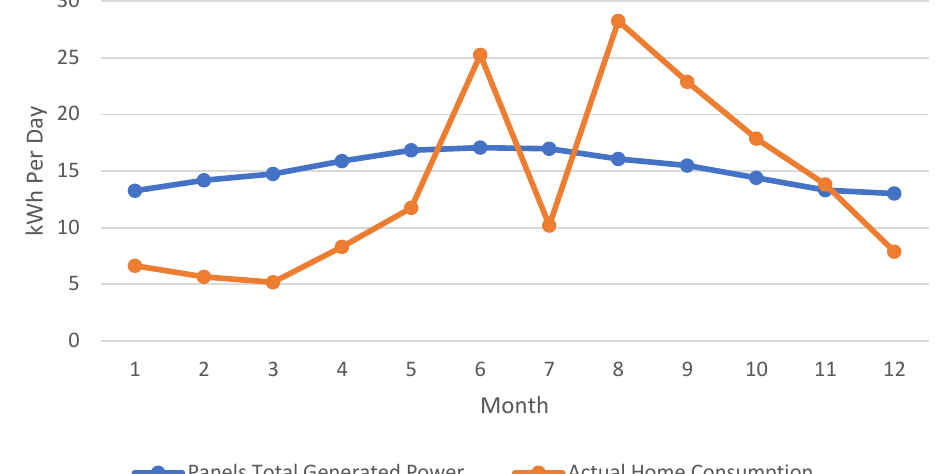
Figure 5. LPE vs. MPN (20% vs. 4 panels) .